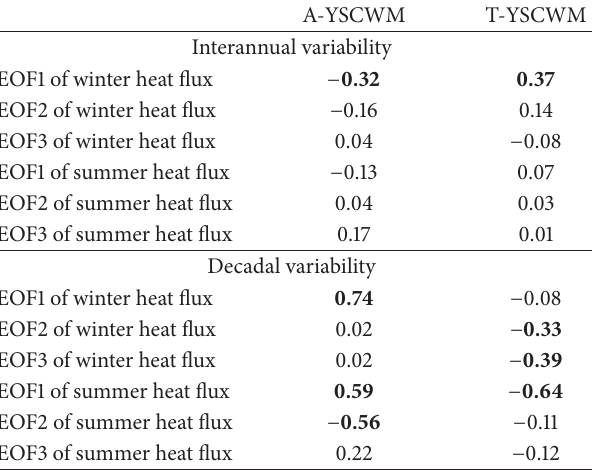
Table 2: Correlation coefficients between EOF1, EOF2, and EOF3 of heat flux and A-YSCWM, T-YSCWM in August, including the interannual and decadal components in both summer and winter. Bold texts indicate that the correlations are statistically significant at the 95% confidence level.